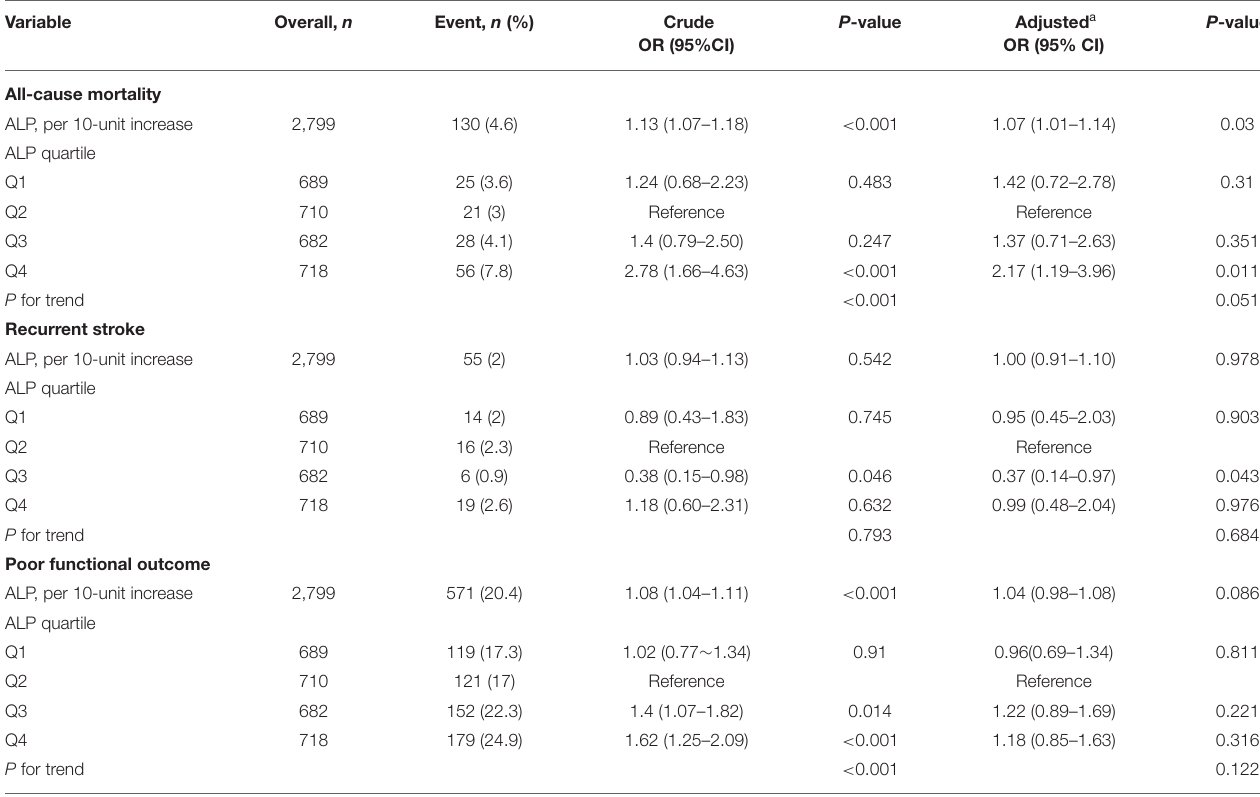
TABLE 3 | Multivariable logistic regression of 3-month